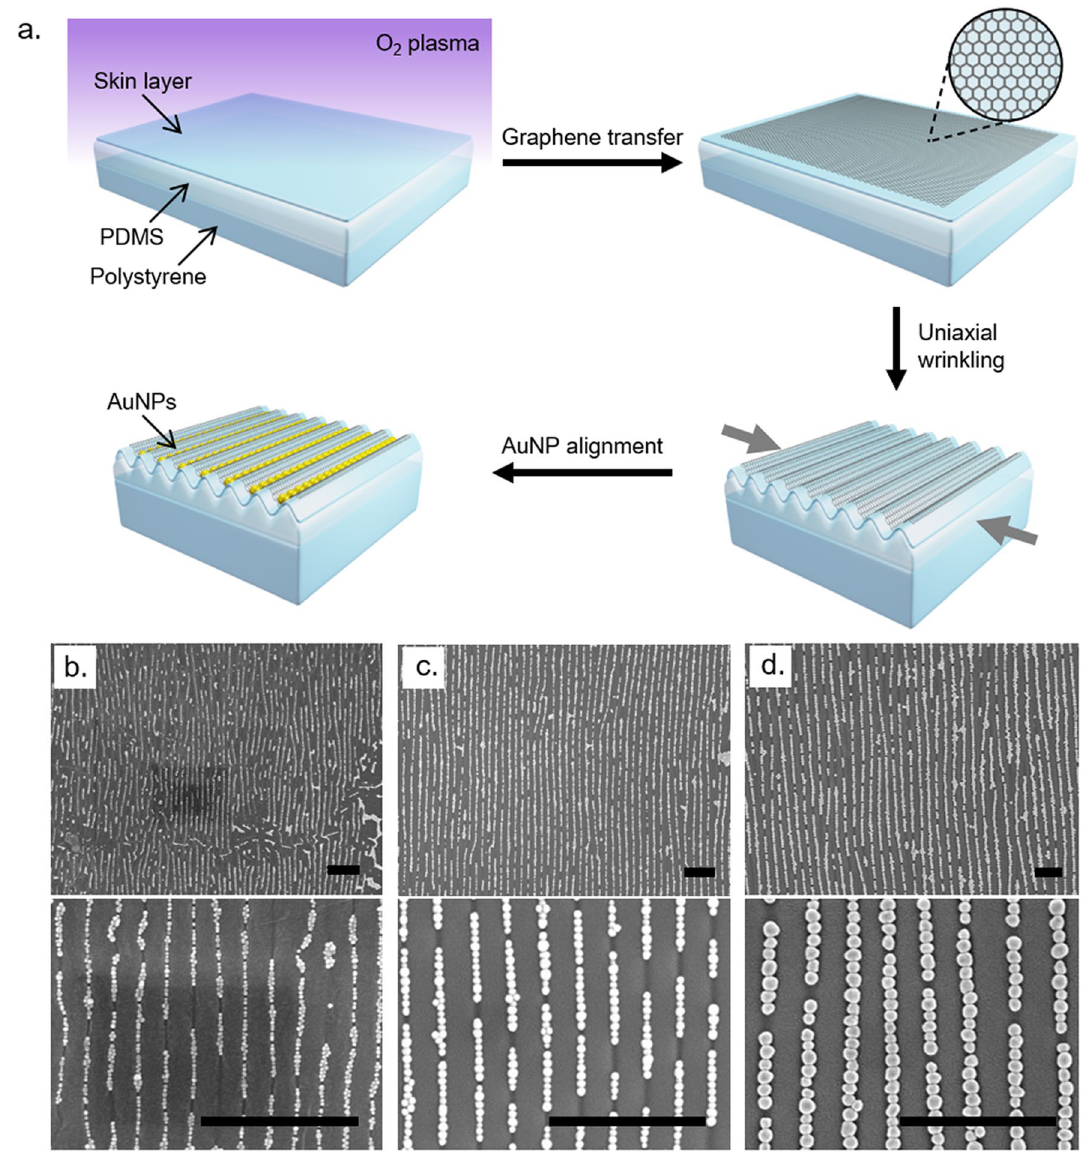
Figure 2. Schematic of conformal graphene wrinkling on PDMS and gold nanoparticle assembly, and SEM images of gold nanoparticles aligned on conformal wrinkled graphene. Schematic of wrinkled substrate assembly and AuNP deposition ( a ), SEM micrographs of 20 nm ( b ), 50 nm ( c ), and 80 nm ( d ) AuNPs on wrinkled graphene. All scale bars 1 μm. Schematic was created with Autodesk 3ds Max software (version 2018, http:// www. autod esk.